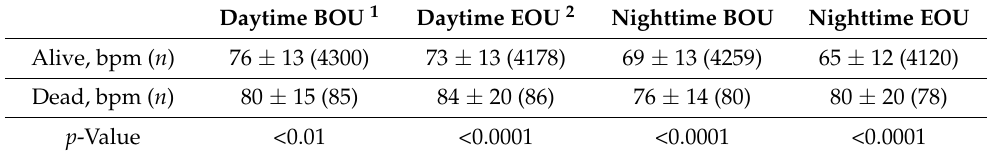
Table 3. Patient outcome with different threshold